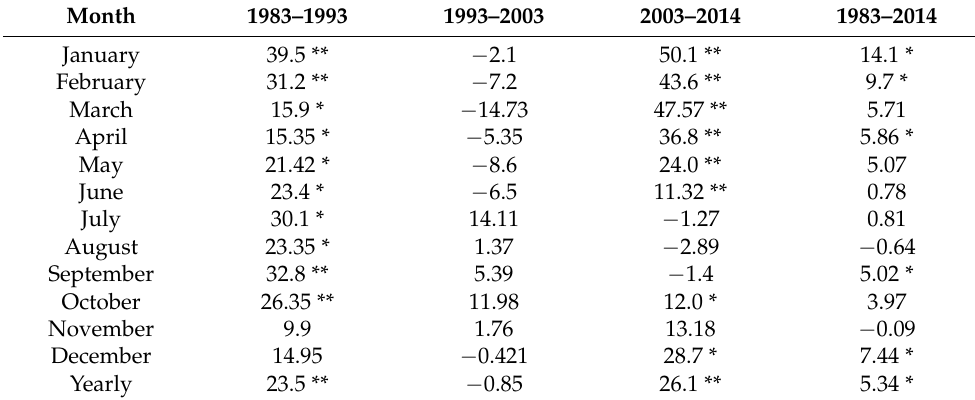
Table 2. Trend analysis of sea-level changes (mm/year) for Cox’s Bazar station.